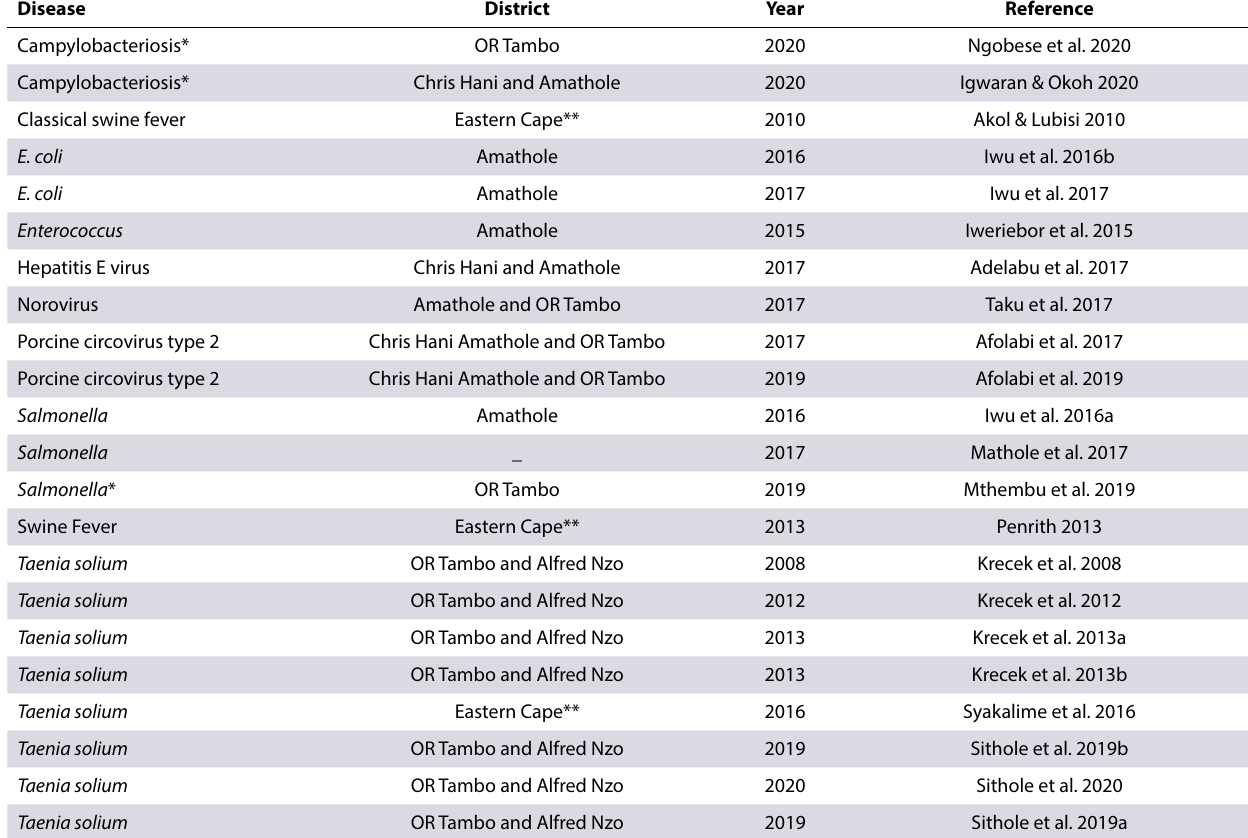
Table I: Pig diseases identified in the Eastern Cape Province between 2000 and 2020 from all databases from Web of Science